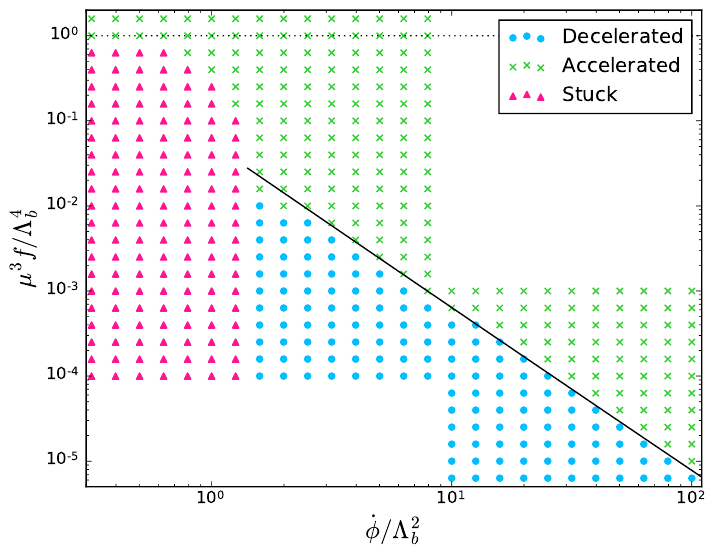
Figure 14 . Phase diagram of axion fragmentation with H = 0. Blue: particle production is e(cid:14)cient enough to stop the axion rolling. Green: the axion is accelerated by the slope and particle production is not e(cid:14)cient enough to stop its rolling. Red: the initial kinetic energy is not large enough to overcome the (cid:12)rst barrier. The black line shows the condition in eq. (3.29), which reproduces the boundary between the blue and the green